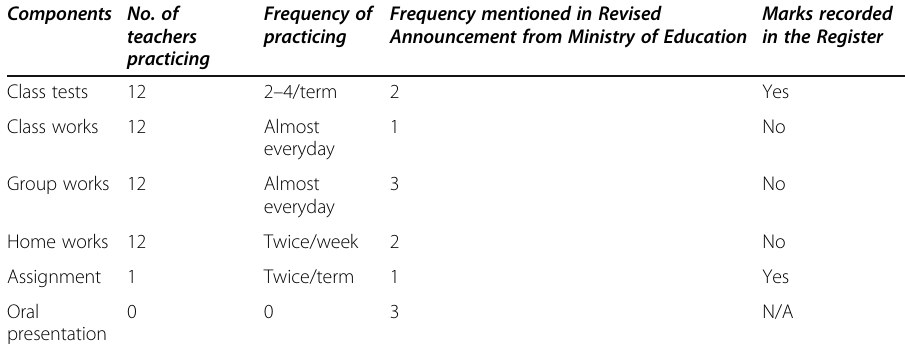
Table 3 Picture of teachers ’ practice of different components of SBA Components No. of